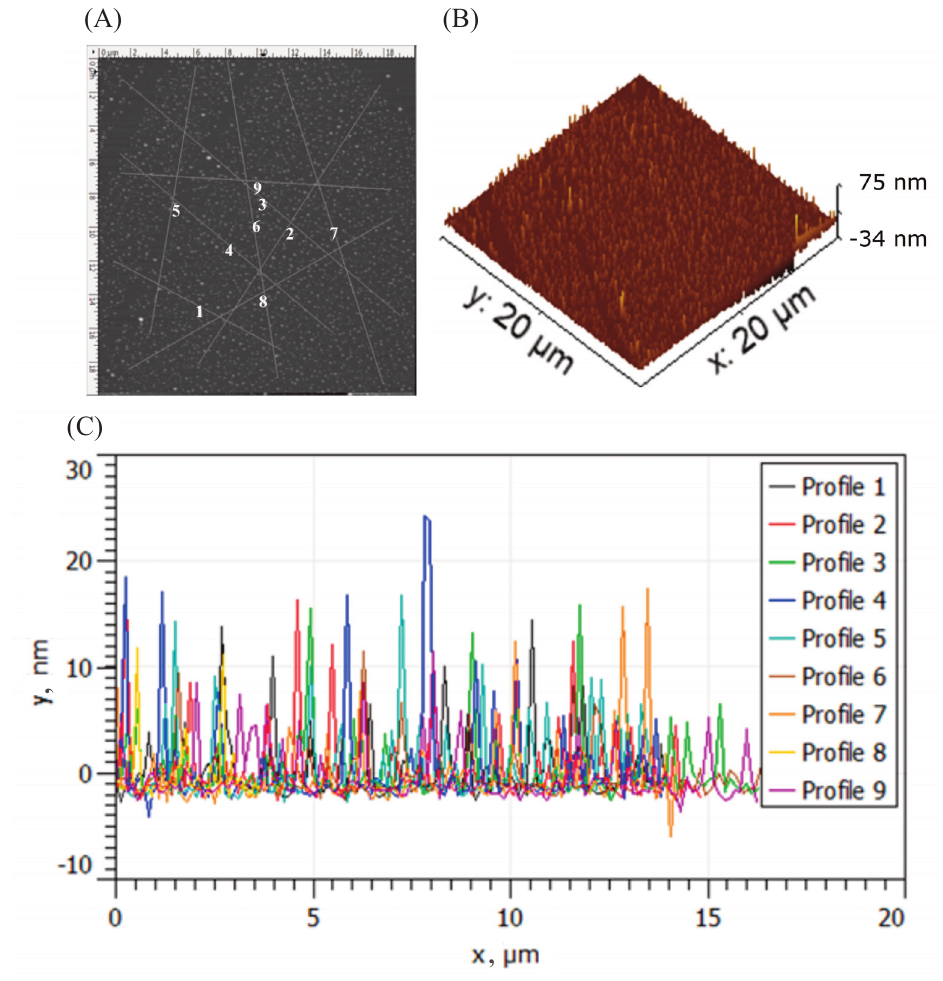
Fig. 3. The topology of the microscopy coverslip (Schott D 263 ® bio) surface after the magnetron sputtering to generate Ti/Au film. The AFM measurements were performed in non­contact mode with the Bruker NEOS 8 equipped with the reflex coating cantilever. The surface topology in 2D (A) and 3D (B) format is shown by a 20 × 20 µm frame with the representative profile of the surface (C).